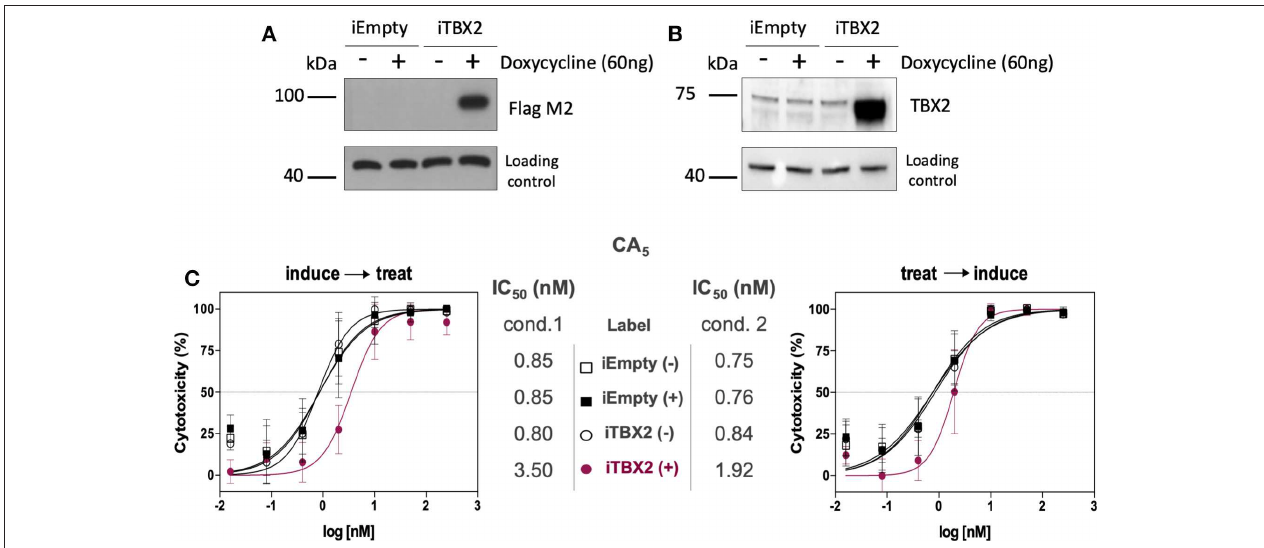
FIGURE 4 | Cell viability assay (MTT) of CA 5 in 501mel cells with induced and non-induced TBX2-overexpression. (A,B) Western blot membranes of samples from iEmpty and iTBX2 cells, without ( − ) and with ( + ) 60ng/mL doxycycline, showing that only iTBX2 ( + ) is inducing TBX2 overexpression; A—probed for anti-Flag M2; B—probed for anti-TBX2. (C) CA 5 cytotoxicity profiles and respective IC 50 (nM) values accessed under cond.1 and cond.2 after 48h drug exposure. IC 50 values were obtained by non-linear regression using GraphPad Prism version 8.0 (GraphPad Software, USA) from three independent experiments performed in duplicate. Cond.1, experiment setup where induction of TBX2 expression was done before drug treatment; Cond.2, experiment setup where drug treatment was done prior to TBX2 induction.